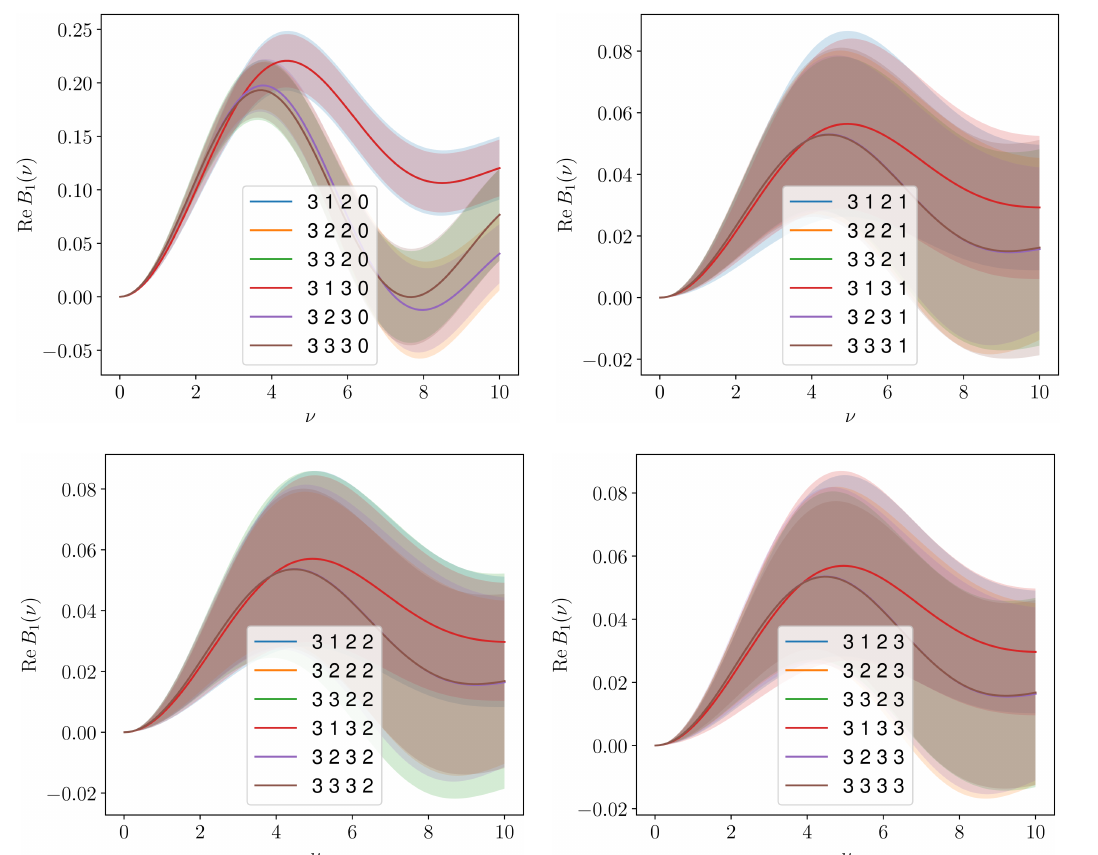
Figure 21 . The higher twist term, B 1 , results from fitting the real component to the models. The numbers in the legend correspond to ( N ± , N